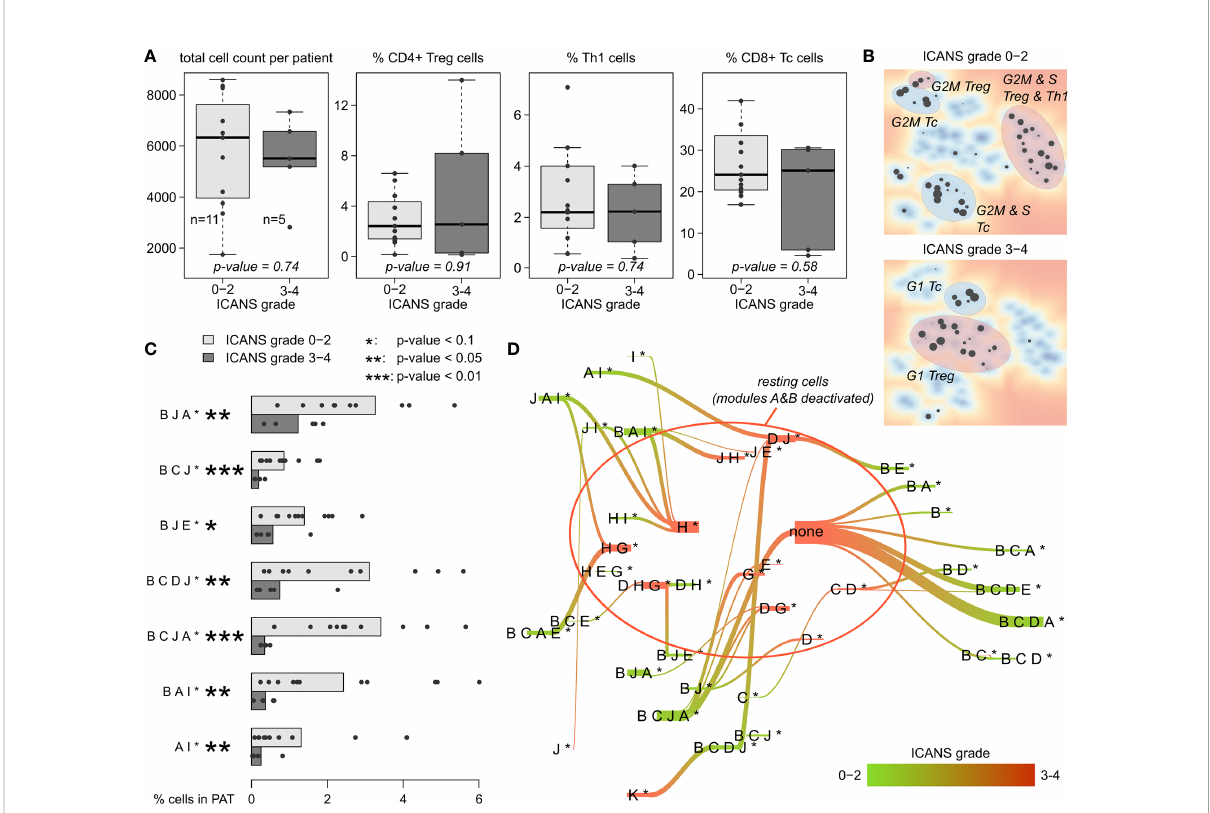
FIGURE 7 T cell subpopulations and expression patterns strati fi ed by neurotoxicity grade: (A) Total cell numbers and relative amount of CD4+ Treg, Th1, and CD8+ Tc cells observed in male patients with ICANS grade 0-2 and 3-4, respectively. P-values were computed using Wilcoxon rank-sum test. (B) Maps of enriched PATs in cells grouped by ICANS grade. T cell subpopulations are highlighted according to Figure 5. (C) Fraction of cells in each male patient classi fi ed into the particular PATs (only PATs with p-value <0.1 in Wilcoxon rank-sum test are shown). Bar lengths represent the mean percentage for the two ICANS groups, the dots represent the individual patients. (D) Virtual PAT fl ow between ICANS groups. PATs on the green colored end of the fl ow are more frequent in ICANS grade 0-2 patient cells, those on the red colored end in ICANS grade 3-4. Width of the fl ow bars scale with the virtual fl